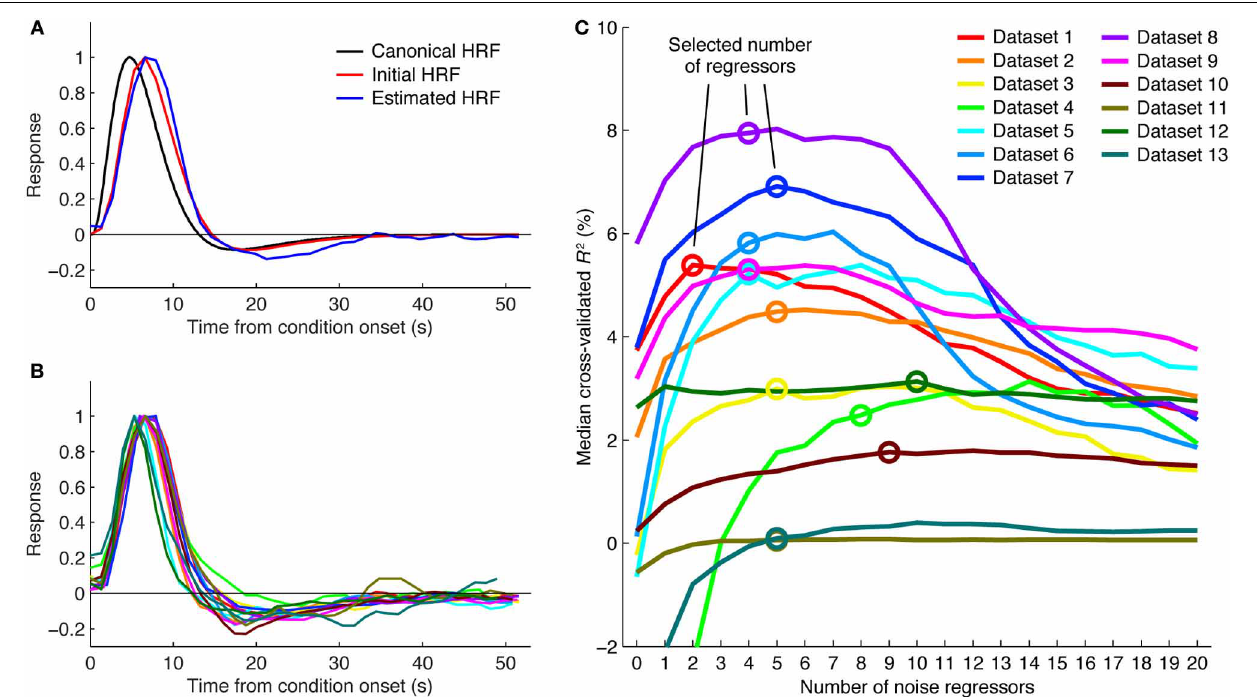
FIGURE 2 | Details of the GLMdenoise fitting procedure. (A) HRF fitting. A canonical HRF representing the response to a brief stimulus (black curve) is convolved with the appropriate square-wave function to predict the response for the condition duration used in a given experiment (red curve). This is the initial seed for the HRF. Iterative linear fitting is then used to estimate the optimal HRF (blue curve). Results are shown for dataset 1 (curves are normalized to peak at one). (B) HRF estimates. Shown are HRF estimates obtained in different datasets. Color